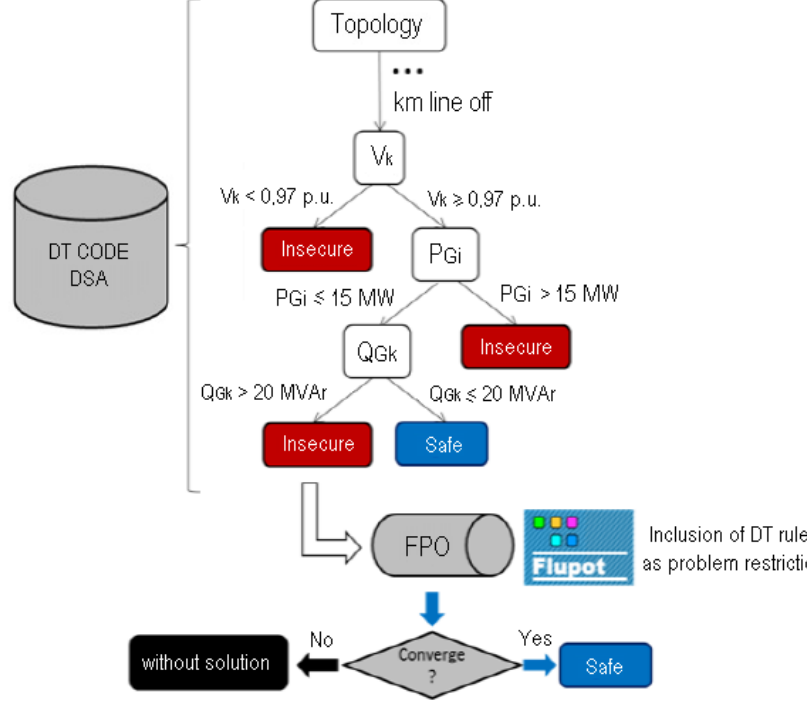
Figure 7. Real-time scheme decision tree-based preventive control module.